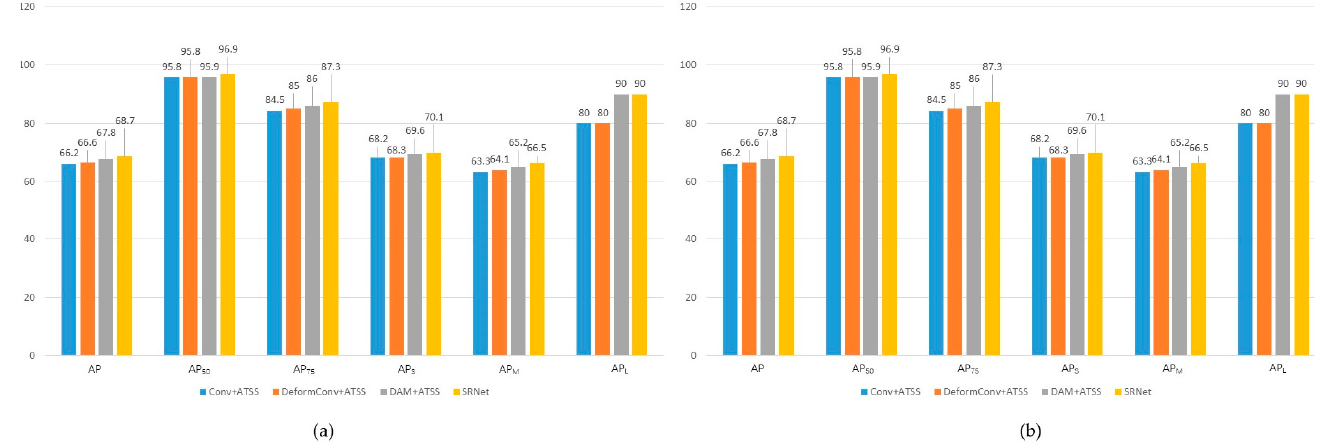
Figure 16. The histograms of ablation experimental results on the SSDD dataset ( a ) and the Instance- RSDD dataset ( b ). RSDD dataset ( b